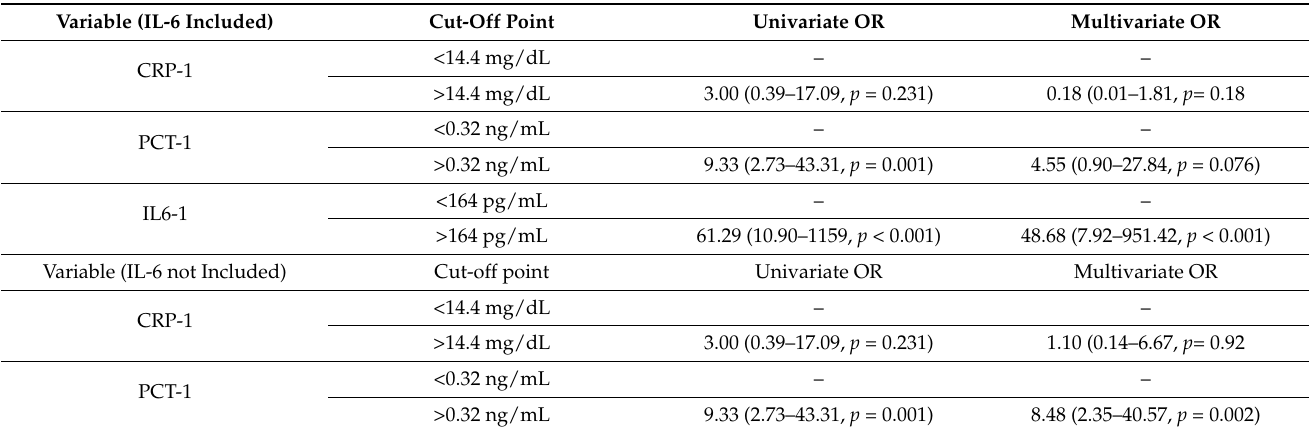
Table 4. Cut-off values and odds ratio (95% confidence interval and p -value) in univariate and multivariate analysis for HRE diagnosis at first evaluation with or without IL-6.